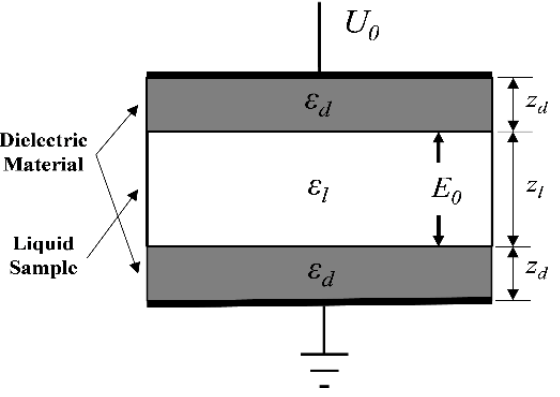
Figure 1. Concept of a PEF chamber with dielectric layers.